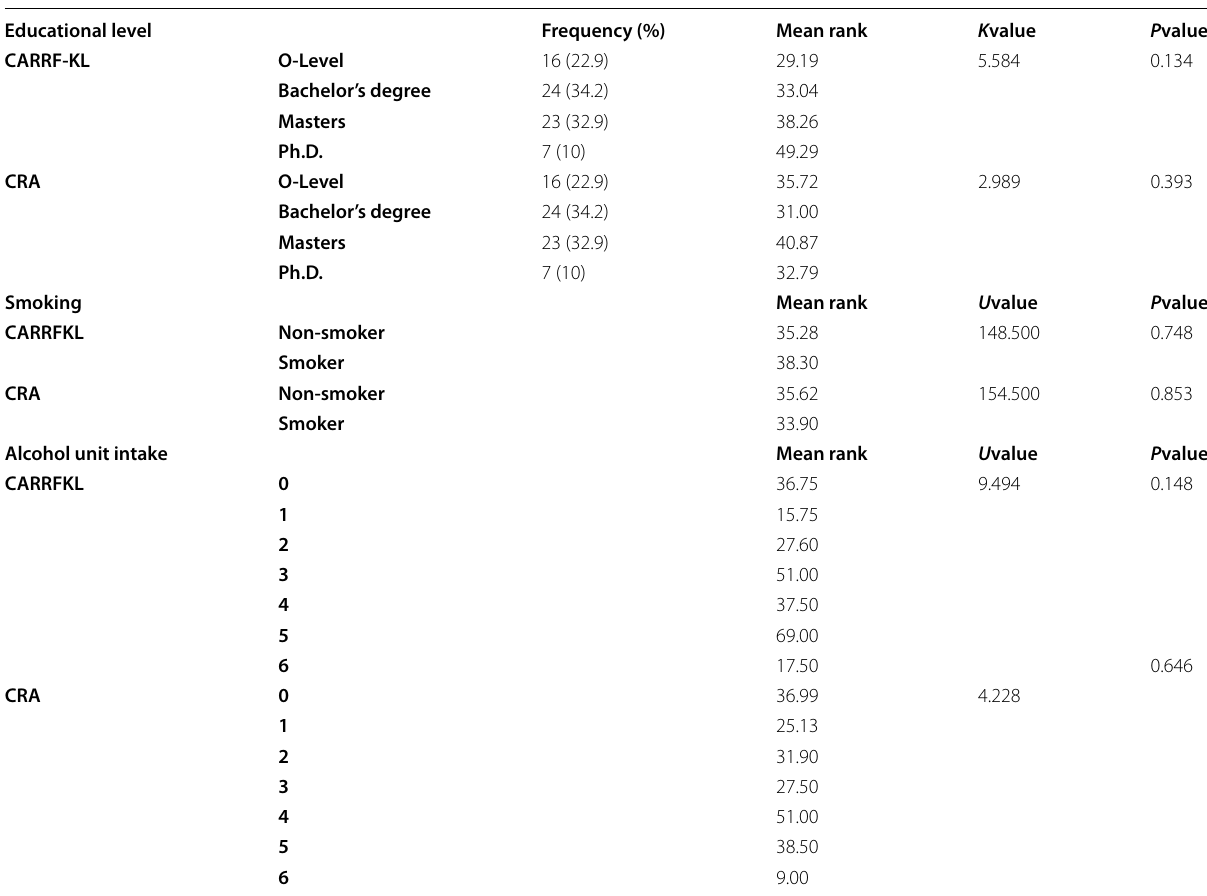
Table 3 Influence of educational levels, smoking, and alcohol unit intake on knowledge and awareness level cardiovascular disease risk